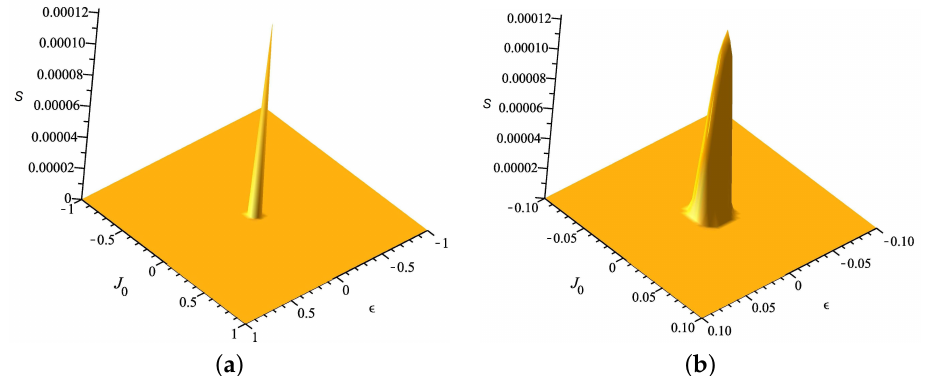
Figure 4. ( a ) Instability region ( S = 0) and stability area ( S > 0) for the frequency ω 2